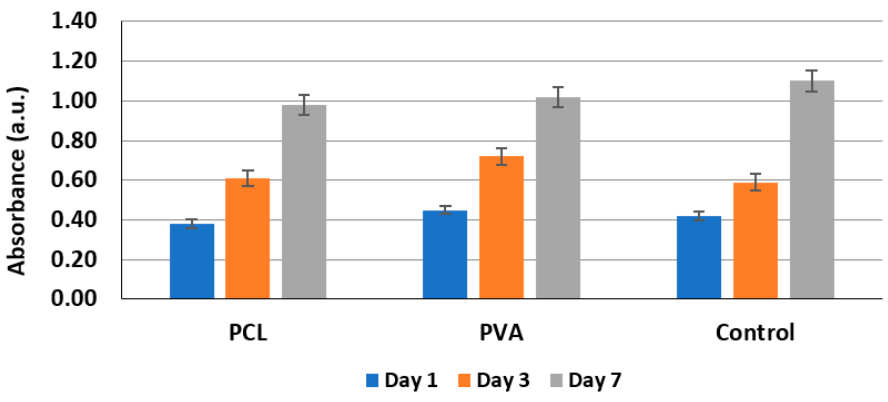
Figure 9. Cell proliferation analysis.